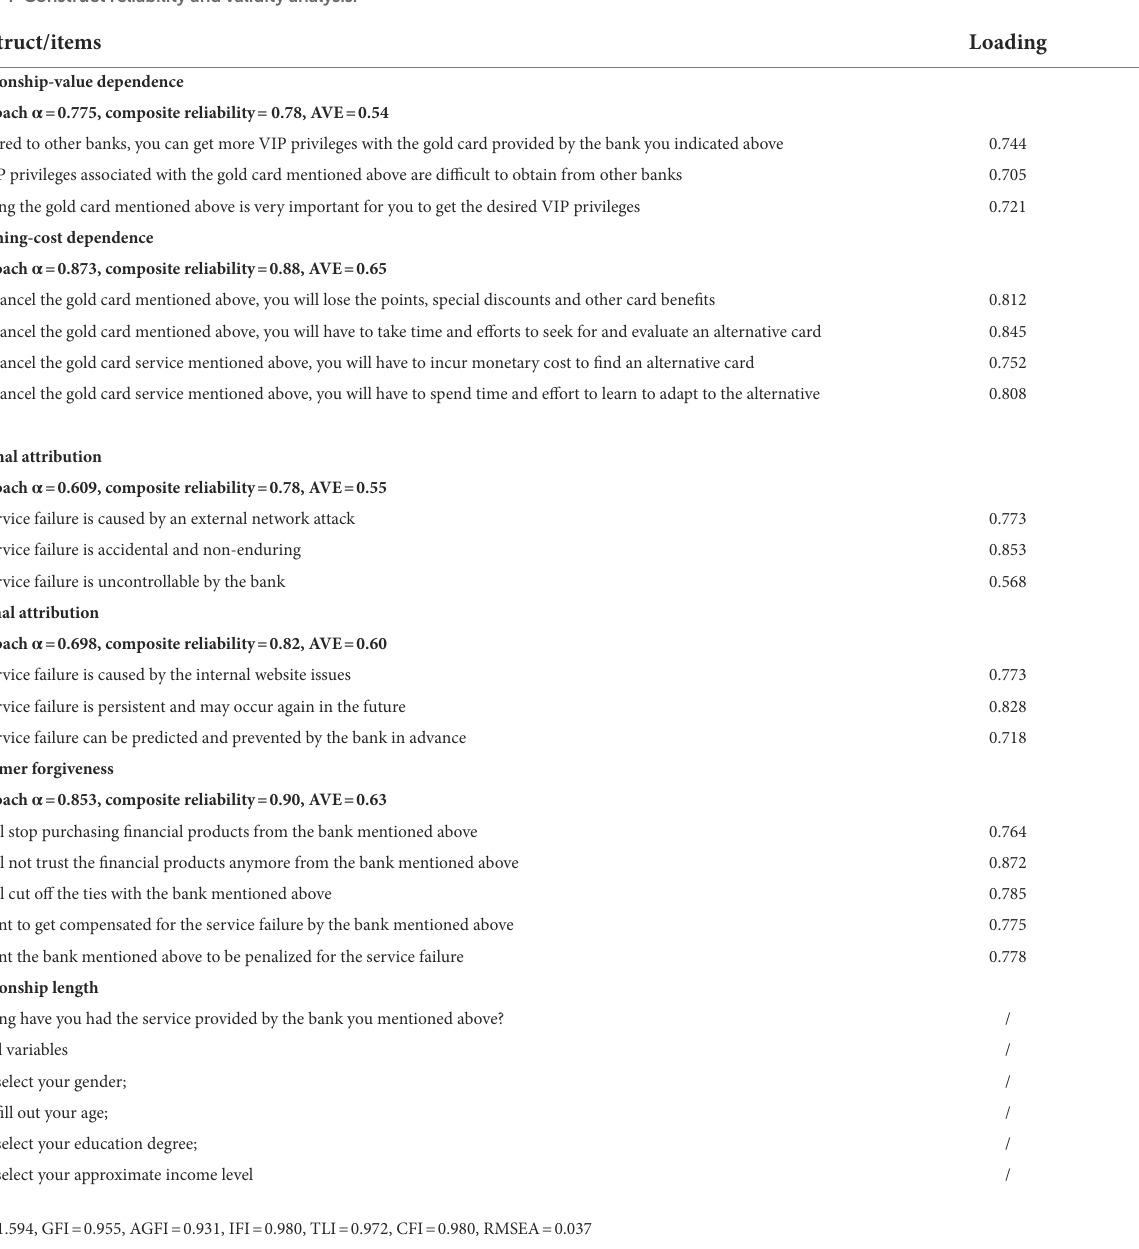
TABLE 4 Construct reliability and validity